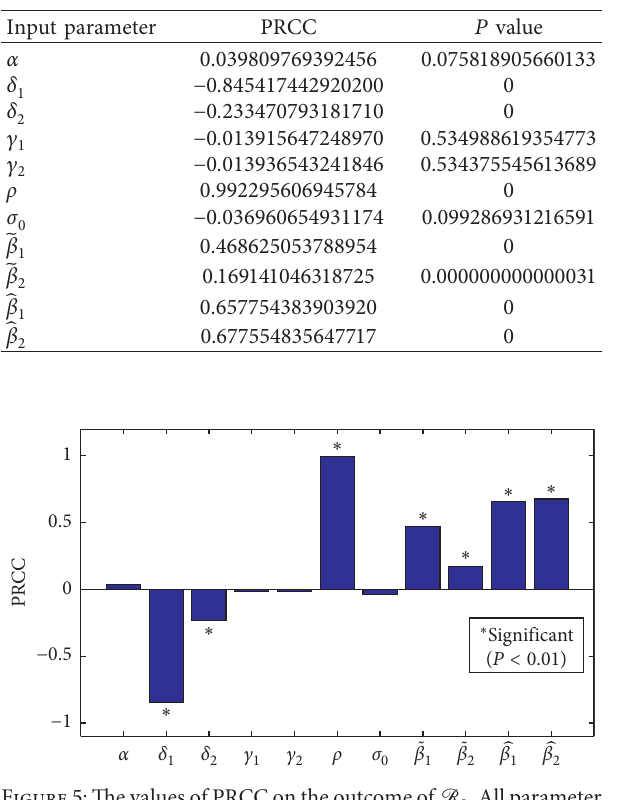
Table 4: PRCC values for R